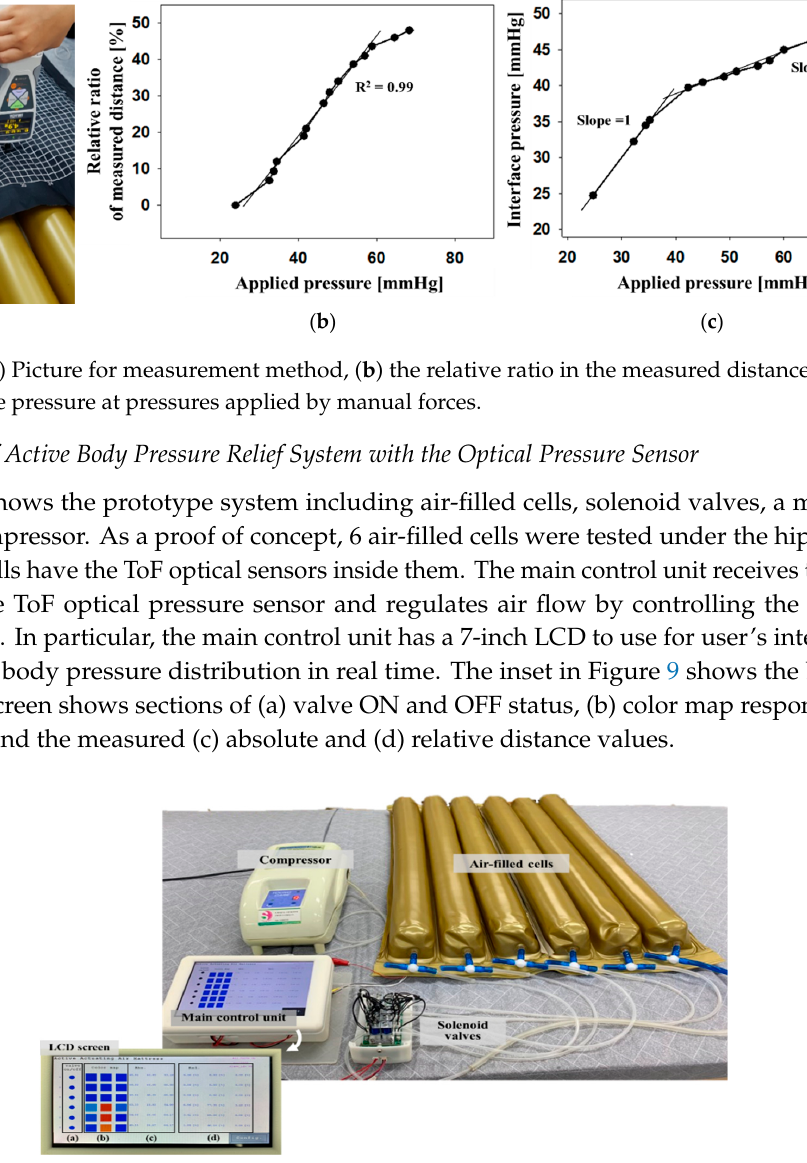
Figure 9. Picture of the prototype system including air-filled cells, solenoid valves, a main control unit and a compressor.